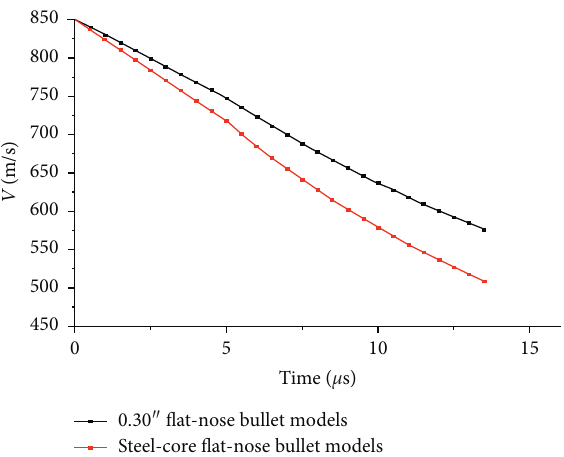
Figure 13: Velocity-time diagram of the bullet (10% 333 FGM + 1mm Al backplate).